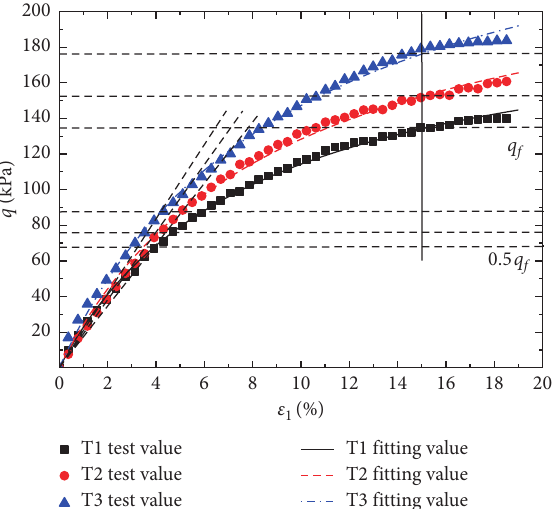
Figure 6: ε 1 ∼ q curves of CD